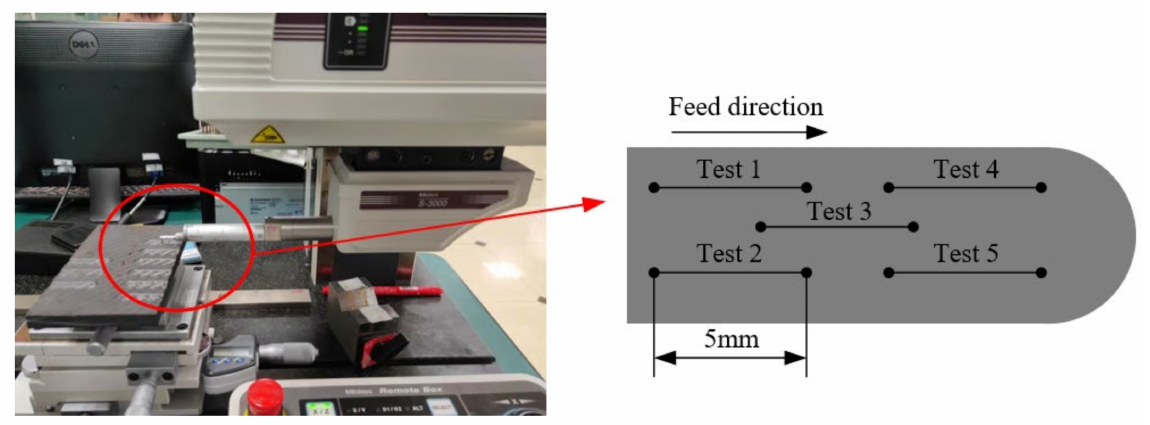
Figure 5. The surface roughness measurement system and measurement